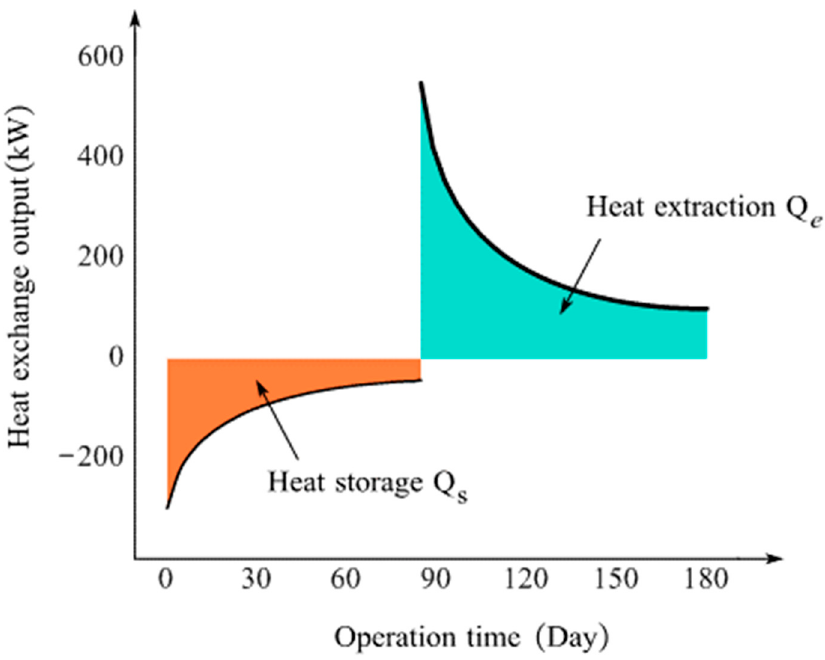
Figure 6. Schematic of heat exchange output during the charging and discharging stage of deep BTES.